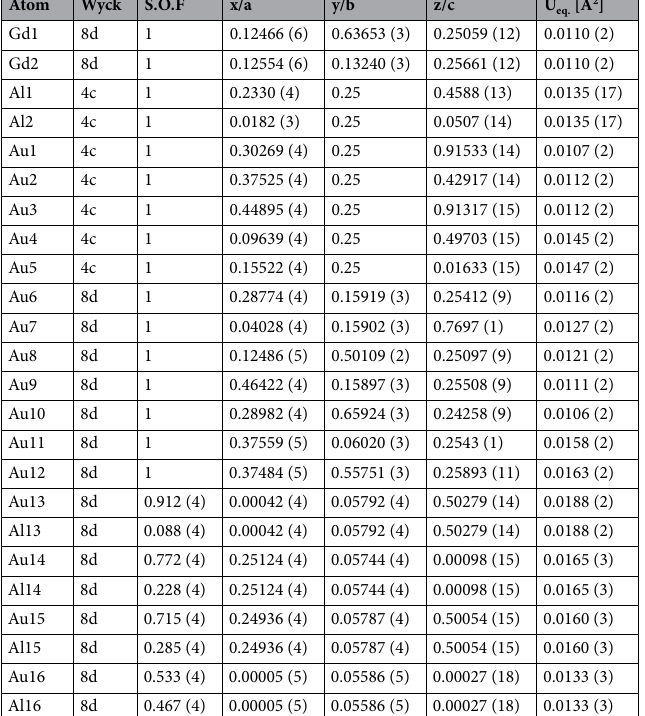
Table 2. Atomic coordinates and equivalent atomic displacement parameters (U eq. ) of independent atomic positions for